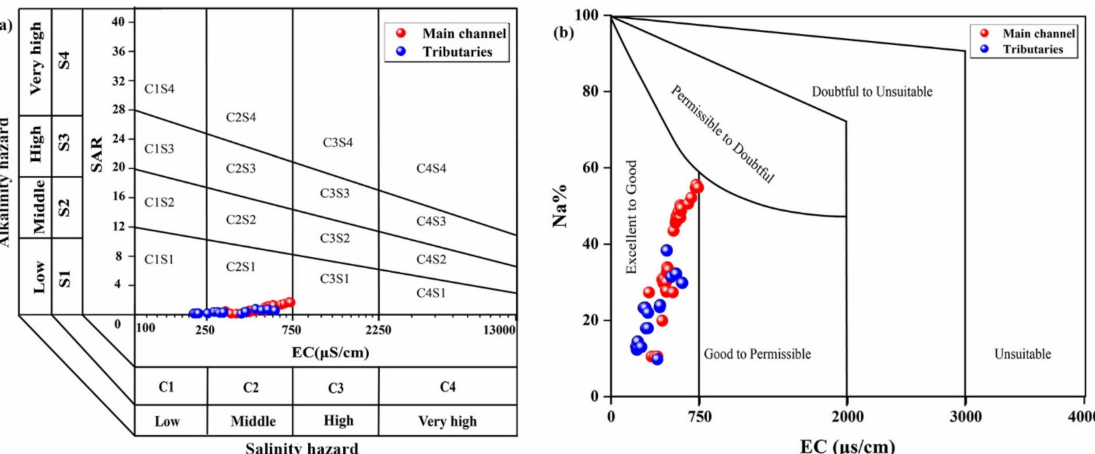
Figure 7. Salinity–alkalinity evaluation of water quality in the TGR. ( a ) Template of USSL; ( b ) template of